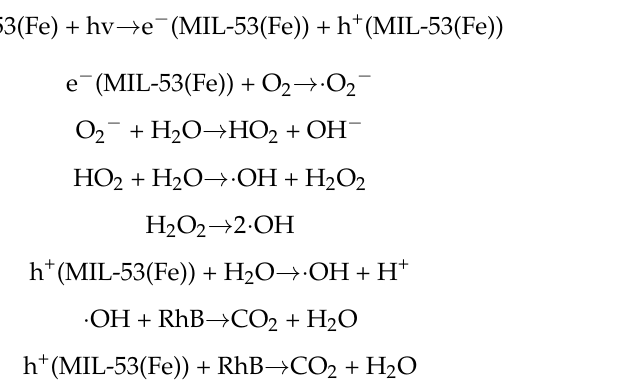
Figure 9. The degradation pathway of RhB 31–35.